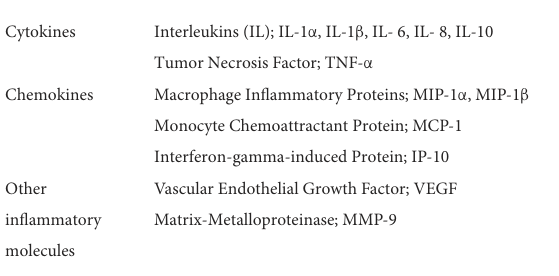
TABLE 1 Panel of inflammatory mediators